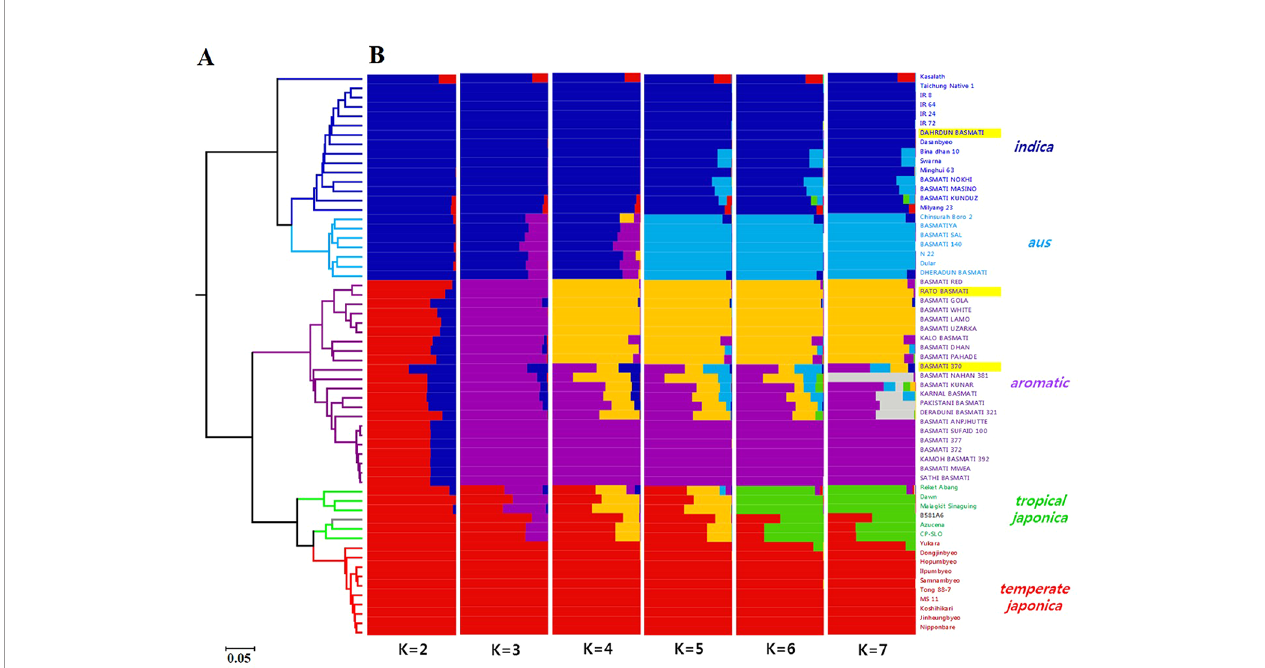
FIGURE 6 | Genetic diversity analysis of 60 rice varieties using 190 SNPs. (A) UPGMA dendrogram. The branches are colored according to the subpopulation assessment in (B) based on K = 6, except for the aromatic group, which is based on K = 3. Gray branches indicate admixture. (B) Population structure analysis using the STRUCTURE software for K values ranging from 2 to 7. Three varieties used for genomic analysis are highlighted in